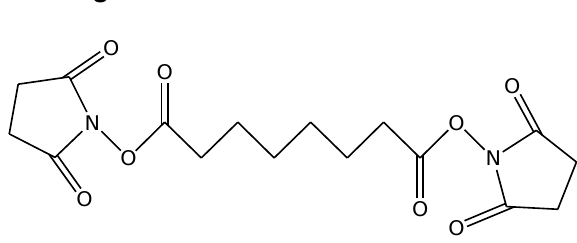
Figure 4. Chemical structure of